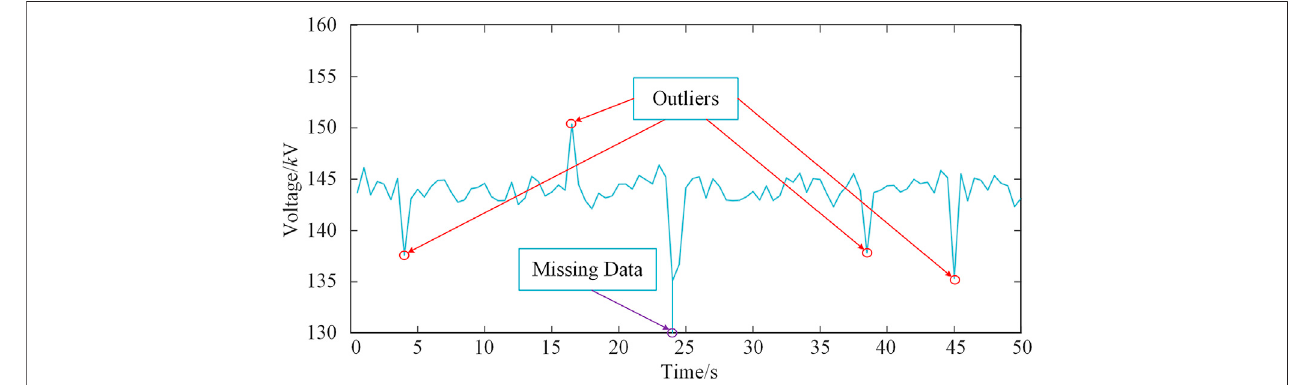
FIGURE 2 | The data anomaly plot.